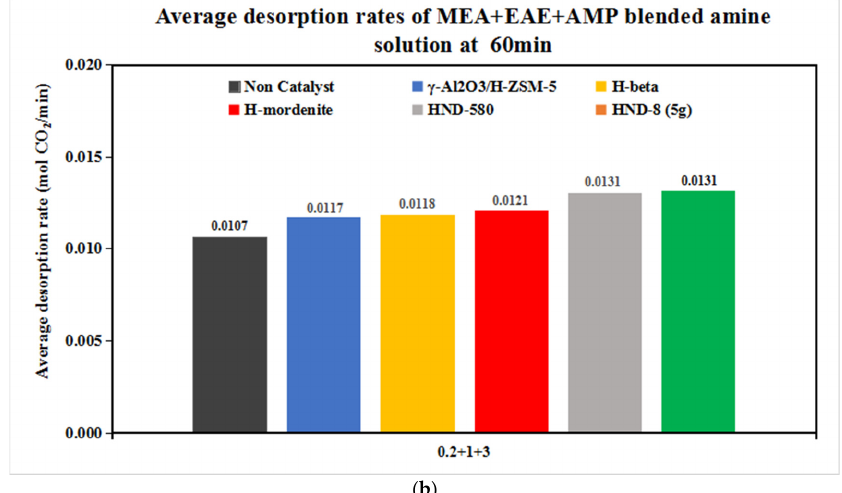
Figure 11. The average desorption rates of MEA + EAE + AMP at 0.2 + 1 + 3 mol/L with catalysts at ( a ) 30 min and ( b ) 60 min.